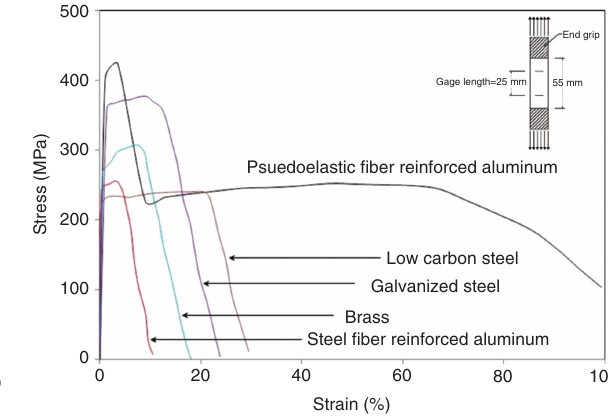
Figure 7 Comparative tensile stress-strain behavior of unnotched specimens.